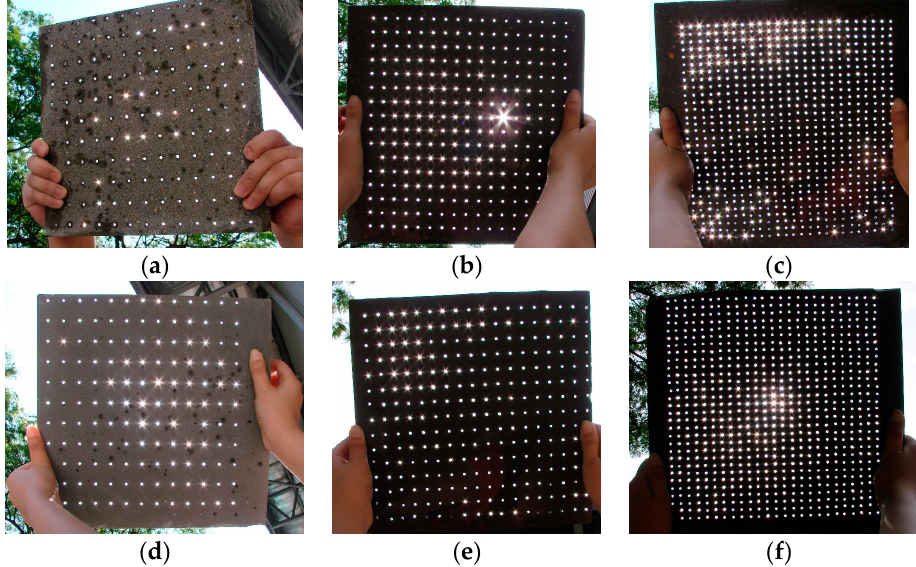
Figure 2. Completed translucent concrete panels (TCPs) (VR = volumetric ratio): ( a ) VR of 1.5% (NWM); ( b ) VR of 3.0% (NWM); ( c ) VR of 6.0% (NWM); ( d ) VR of 1.5% (LWM); ( e ) VR of 3.0% (LWM); ( f ) VR of 6.0% (LWM).